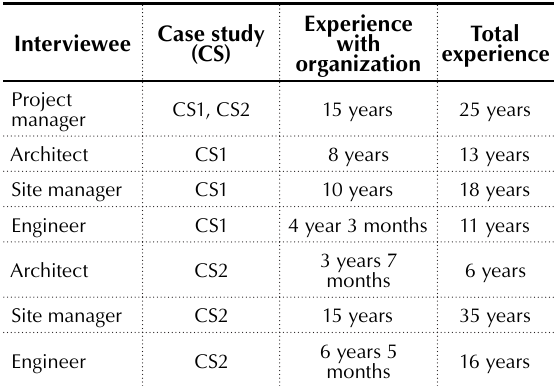
Table 1. Interviewee’s profile